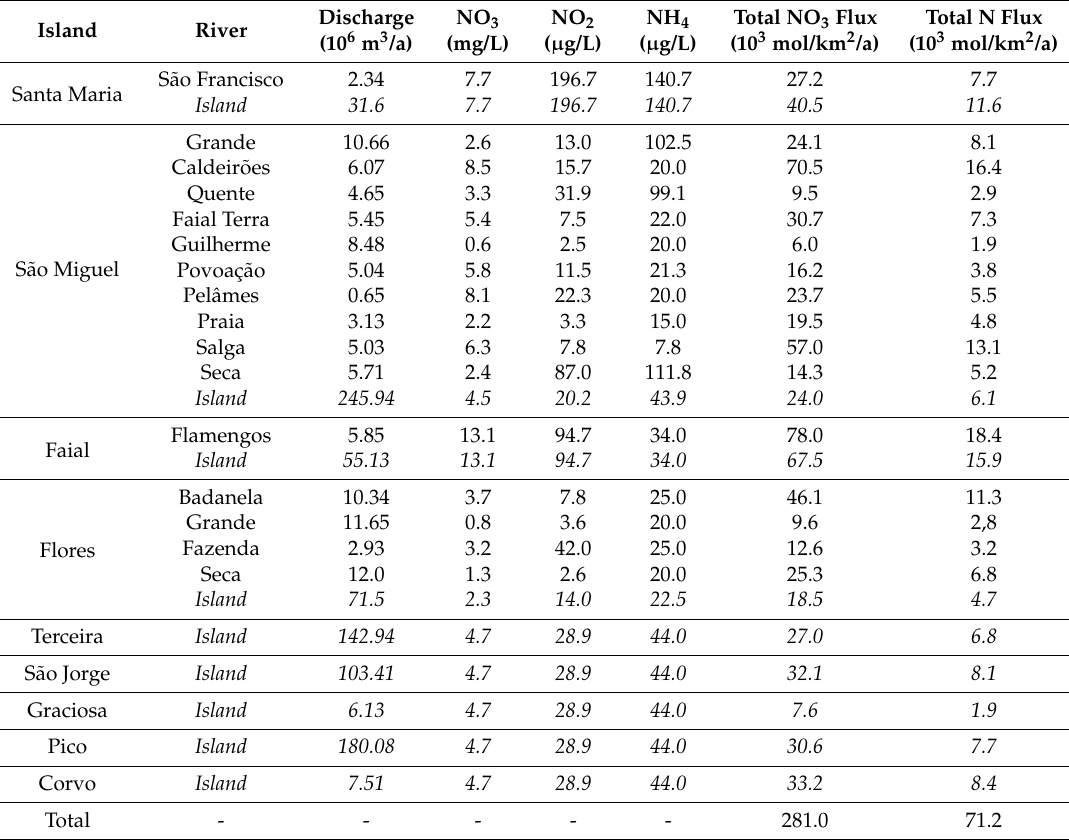
Table 2. NO 3 and total N fluxes in rivers (discharge values and chemical data from [45]).